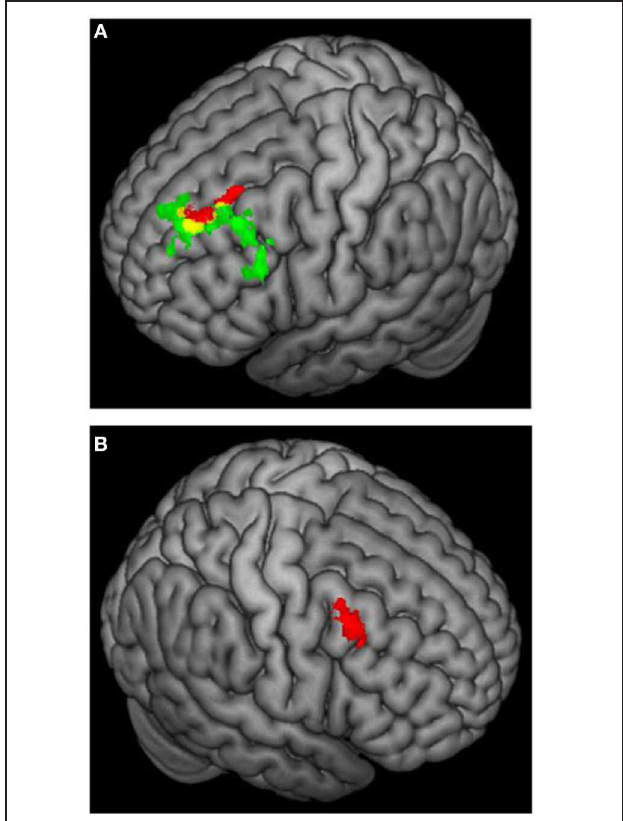
FIGURE 6 | 3D rendering of fMRI activation moderated by approach and avoidance temperament. (A) Activation for incongruent vs. congruent contrast correlating positively with approach temperament (green) or positively with avoidance temperament (red); yellow = overlap in activation. (B) Activation for incongruent vs. congruent contrast correlating positively with avoidance temperament. From Spielberg et al. (2011). Copyright Elsevier